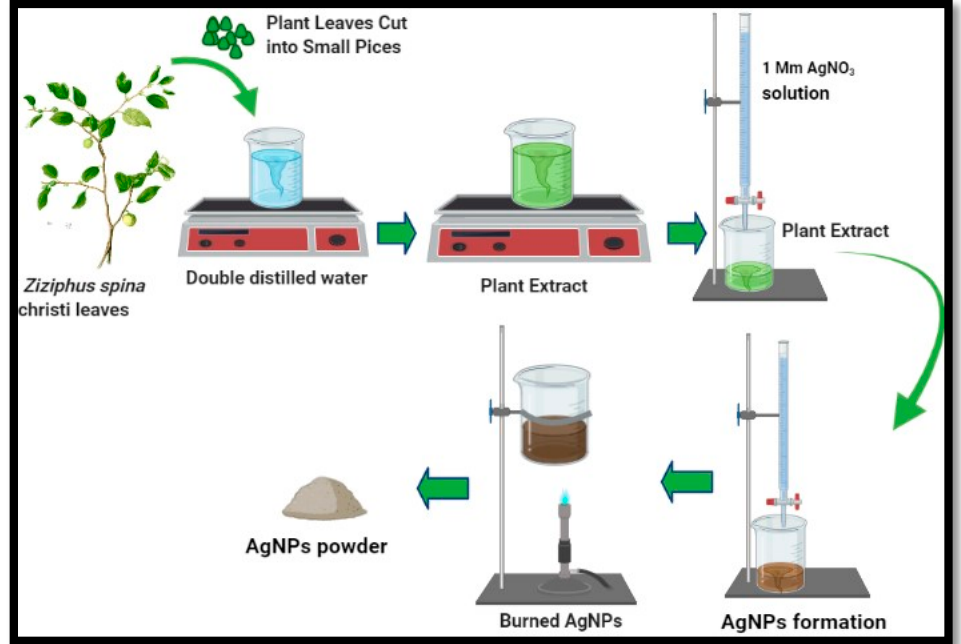
Figure 1. Schematic illustration of the green synthesis of silver nanoparticles using Z. spina-christi (sidr) leaf extract: 100 mL of (1 mM) AgNO 3 solution was added to 10 mL of the plant extract on a hotplate, then the color change was monitored.